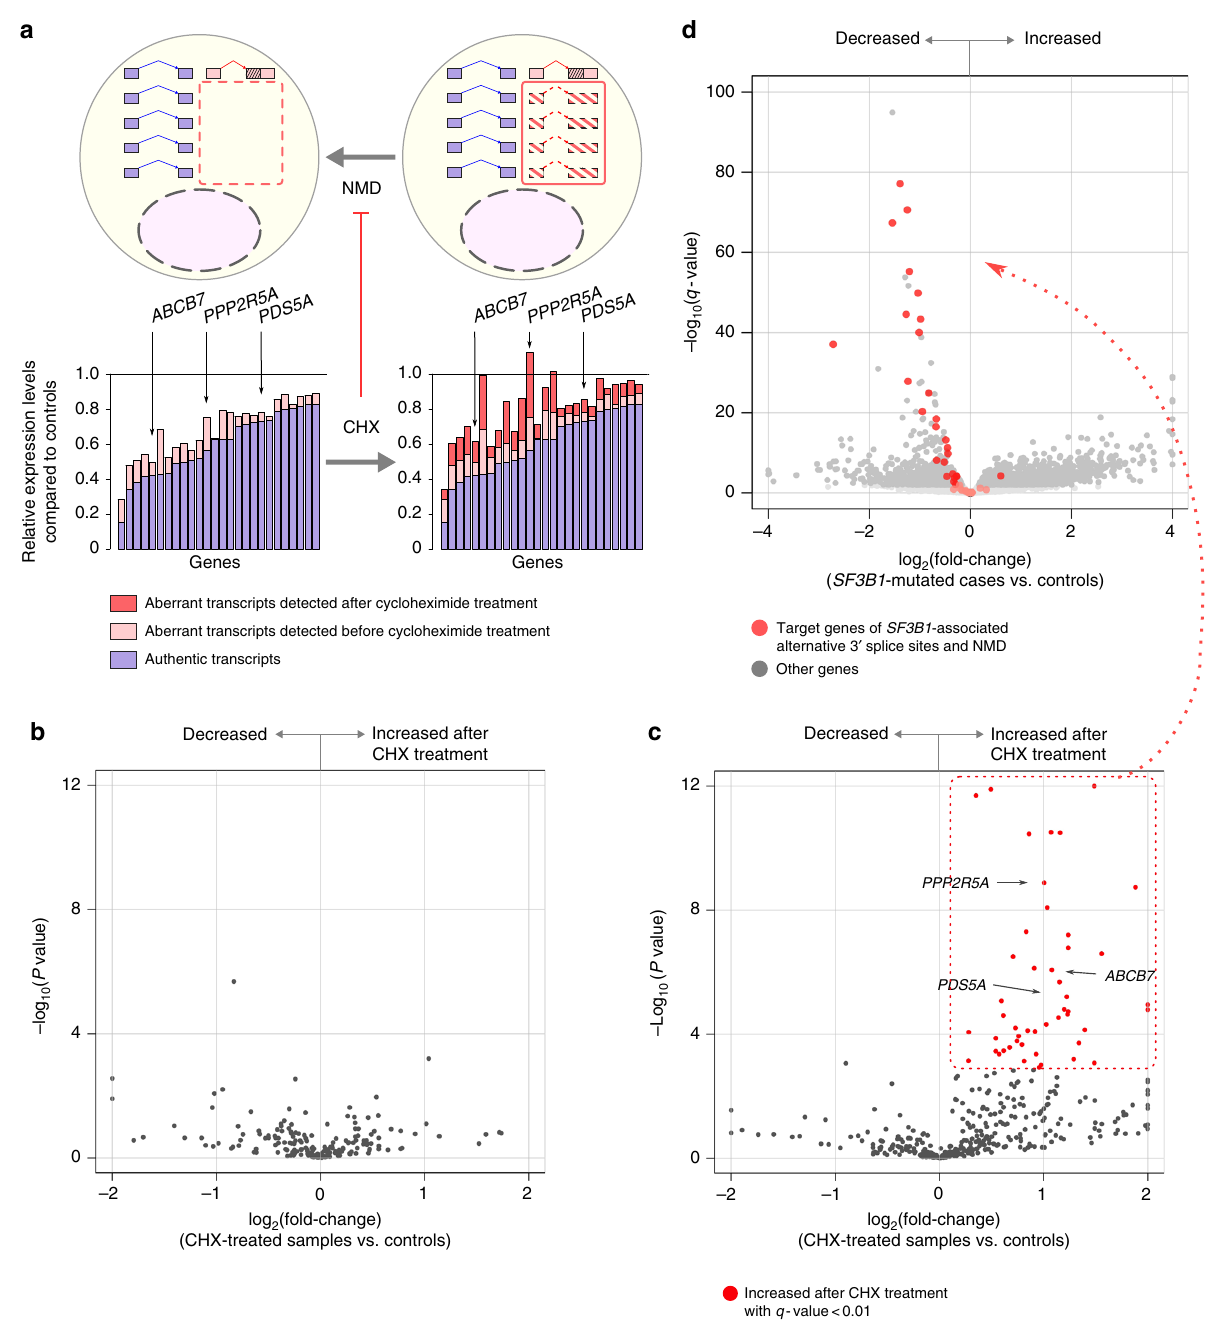
Fig. 4 Nonsense-mediated decay of aberrant transcripts and downregulation of target genes. a Relative expression of some target genes of mutant SF3B1 - associated alternative 3 ′ splice sites in the SF3B1 -mutated CD34 + cells as compared with those without SF mutations. Blue bars indicate expression levels of the authentic transcripts. Pink and red bars indicate those of the aberrant transcripts detected before and after CHX treatment, respectively. These genes had a seemingly small amount of the aberrant transcripts that increased after CHX treatment. b , c Volcano plots comparing PSI values of SF3B1 -associated splicing alterations between samples with and without CHX treatment ( n = 4 each). Alternative splicing events were separately plotted for non-truncating events ( b ) and truncating ones ( c ). X -axis indicates fold changes in PSI values after CHX treatment on a log 2 scale. Y -axis indicates P values on a negative log 10 scale. Transcripts increased after CHX treatment with a q -value <0.01 were regarded as sensitive to NMD. d A volcano plot comparing gene expression levels between the SF3B1 -mutated CD34 + cells ( n = 32) and those without known SF mutations ( n = 41). X -axis indicates fold changes in gene expression on a log 2 scale. Y -axis indicates q -values on a negative log 10 scale. Target genes of mutant SF3B1 -associated alternative 3 ′ splice sites and NMD are depicted in